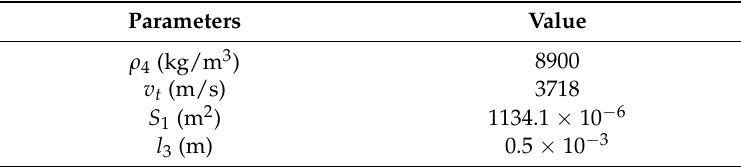
Table 4. The material parameters of the copper used in the metal